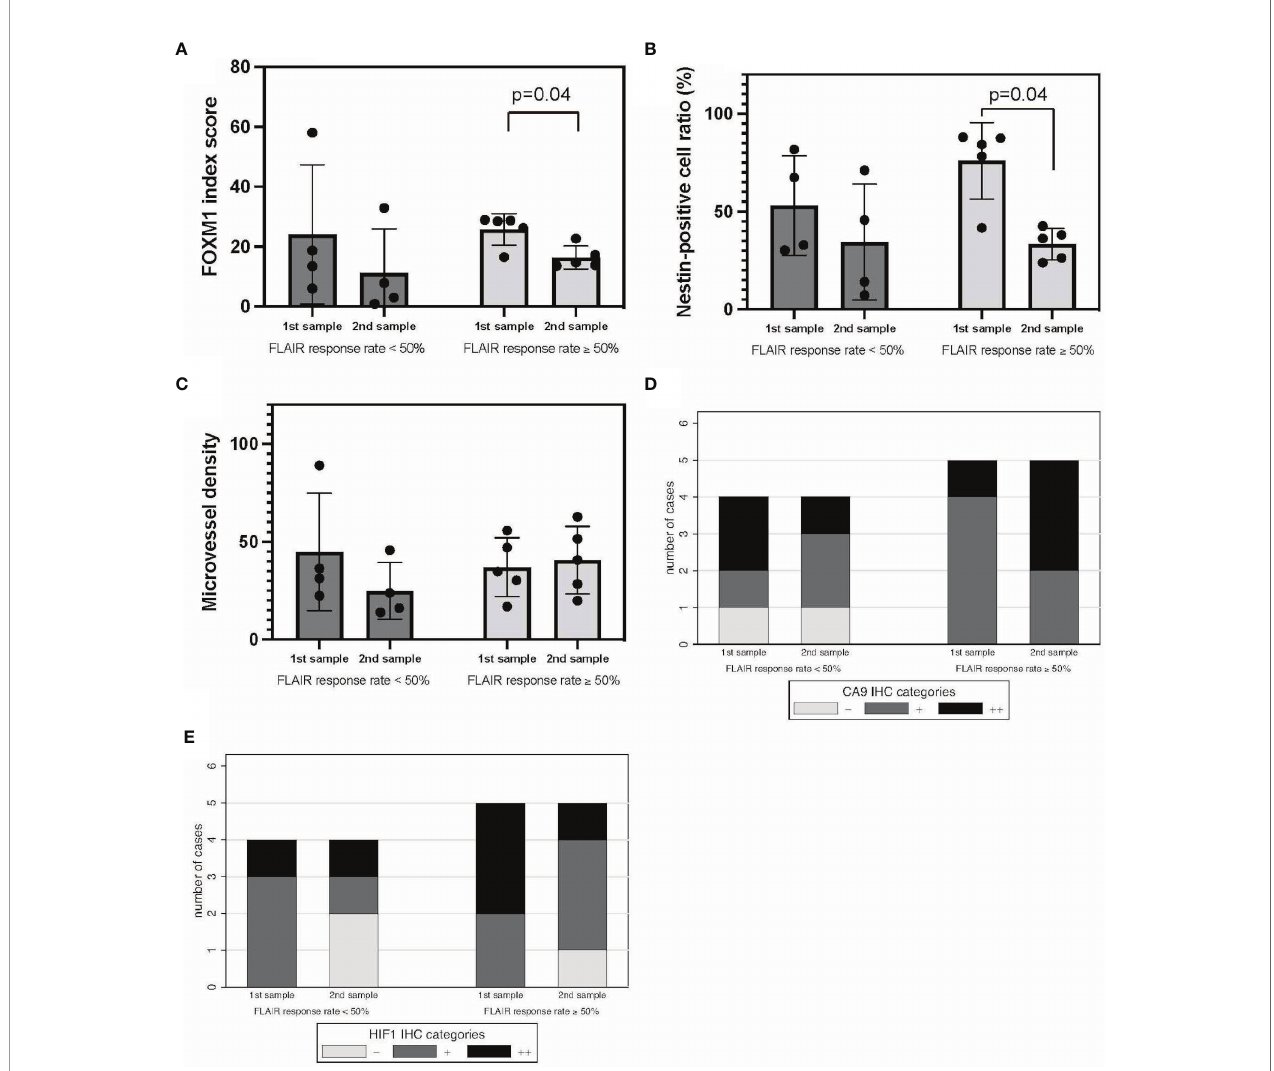
FIGURE 5 | FLAIR-GRs vs. FLAIR-PRs in tumor oxygenation, stemness, and immunological TME. FOXM1 (A) , nestin (B) , MVD (C) , CA9 (D) , and HIF-1 a expression (E) . Error bar; standard deviation. CA9, carbonic anhydrase 9; FLAIR, fl uid-attenuated inversion recovery; FOXM1, Forkhead box M1; GR, good rensponder; HIF-1 a , hypoxia inducible factor-1 alpha; MVD, microvessel density; PR, poor responder; TME, tumor